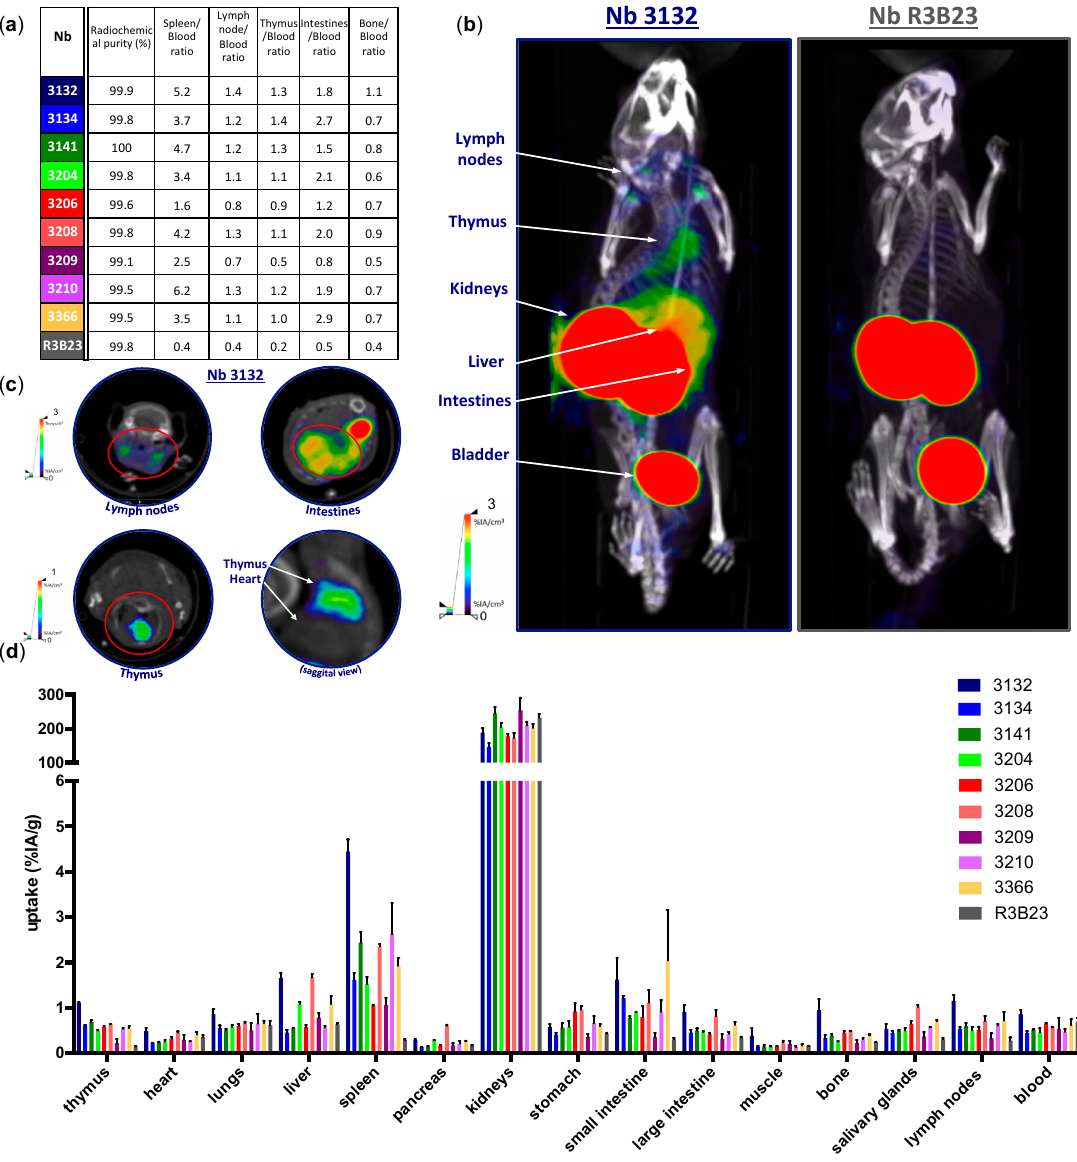
Figure 2. Single photon emission computed tomography (SPECT) / CT imaging and biodistribution of Nbs in naive C57BL / 6 mice. ( a ) Radiochemical purity of in vivo injected 99m Tc-Nb conjugates and the ratio between the uptake of the Nbs in the spleen, thymus, intestines, lymph nodes, and bones with the uptake values found in the blood ( n = 1). ( b , c ) SPECT / CT imaging of mice 60 min after intravenous injection of 99m Tc-labeled anti-moLAG-3 Nbs 3132 and 3206, showing specific signals in the lymph nodes, intestines, thymus, and bone marrow as compared to control Nb R3B23. The data shown are representative for three mice ( n = 1). ( d ) Ex vivo γ -counting of the isolated organs from healthy C57BL / 6 mice 80 min after injection with 99m Tc-labeled anti-moLAG-3 Nbs or control Nb R3B23. The graph summarizes the biodistribution of the Nbs in three mice, expressed as mean ± SD of percentage of injected activity per gram of organ or tissue (%IA/g) ( n = 1).